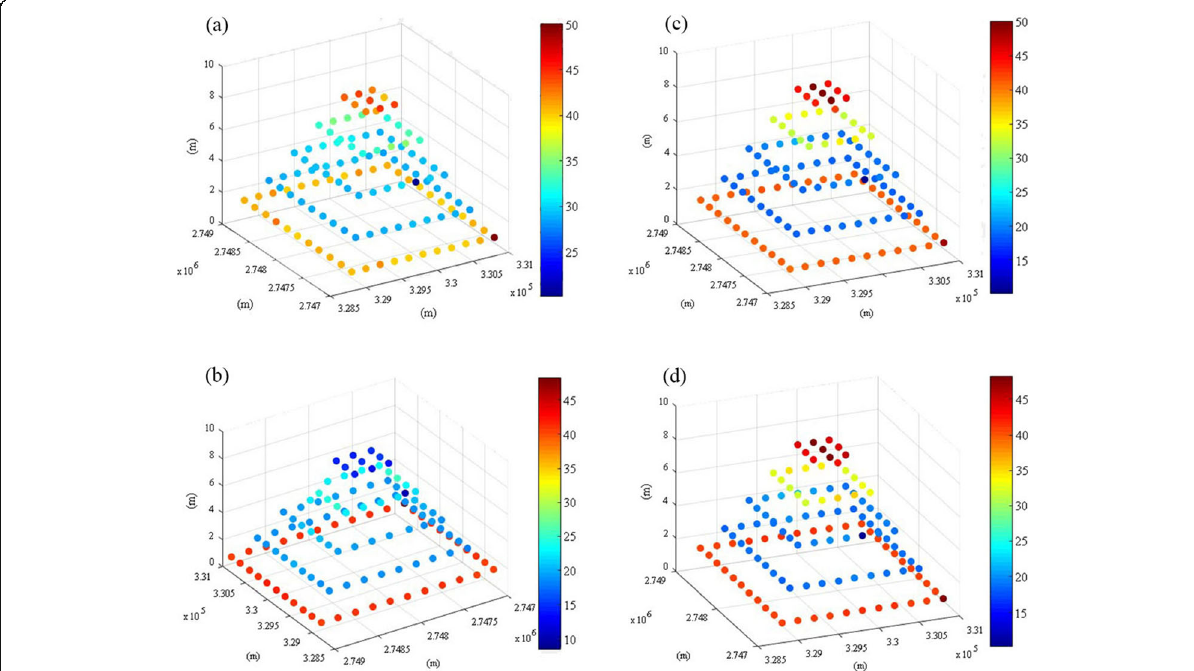
Fig. 10 PM 2.5 spatial distributions during rush hours: a on weekday afternoons; b on weekday mornings; c on weekend afternoons; d on weekend